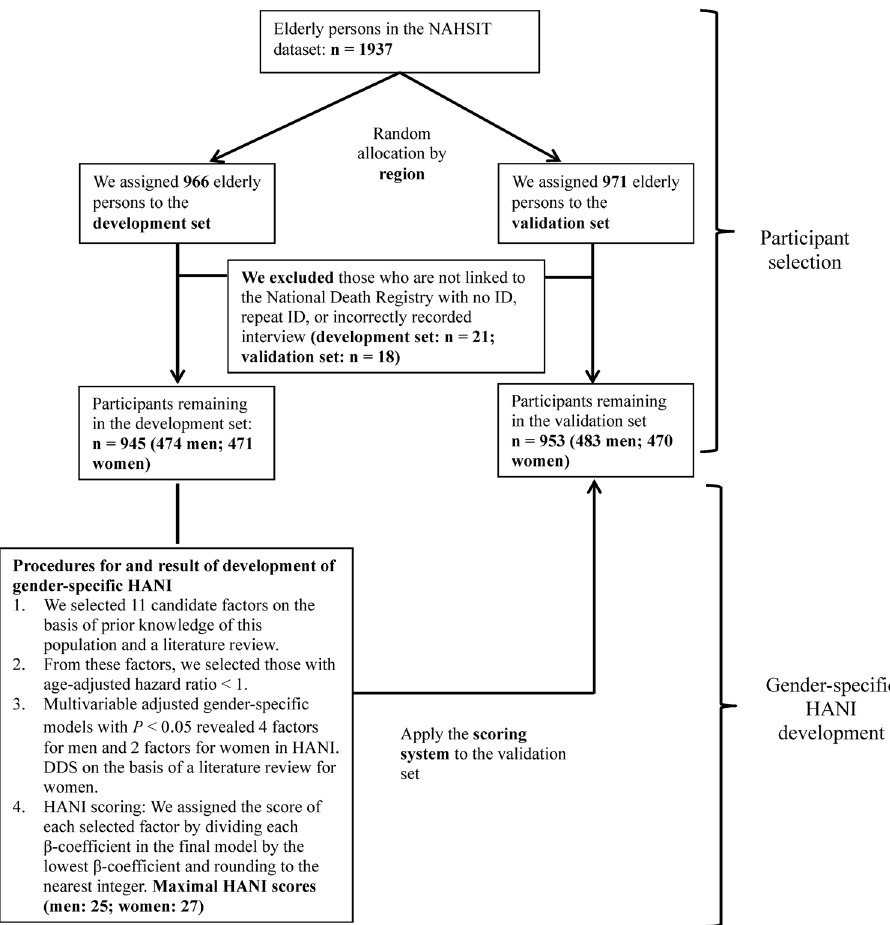
Figure 4. Flow chart of participant selection and procedure for the development of gender-specific HANI. NAHSIT, Nutrition and Health Survey in Taiwan; HANI, Healthy Ageing Nutrition Index; DDS, dietary diversity